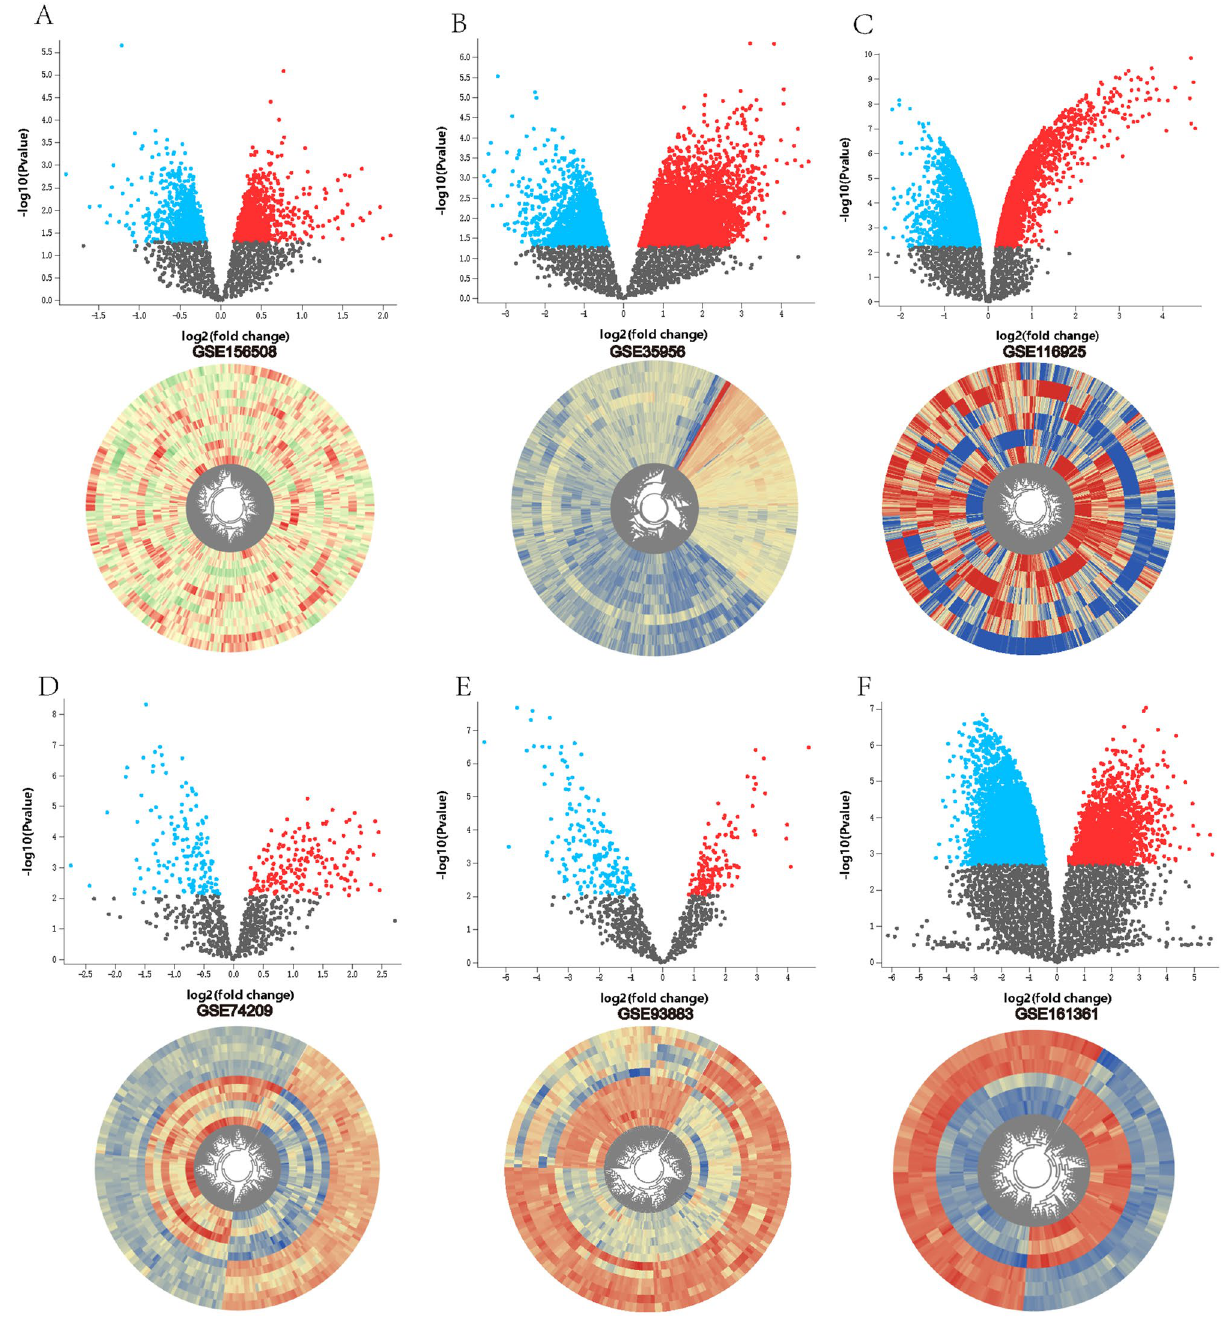
Figure 2. Volcano plots and heatmaps of microarray datasets. ( A ) GSE158508, ( B ) GSE35956, ( C ) GSE116925, ( D ) GSE74209, ( E ) GSE93883, ( F )